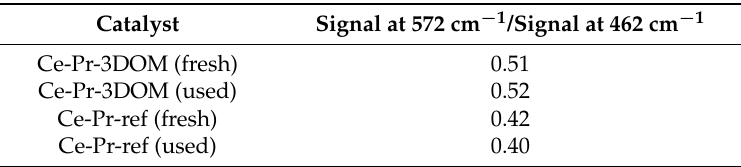
Table 2. Relative signal of selected Raman bands (vacancies/F 2g